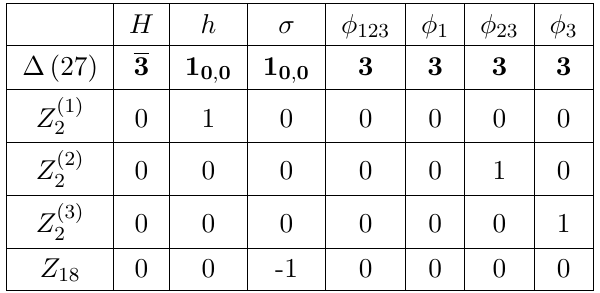
Table 1 . Scalar assignments under the ∆ (27) × Z (1) between the multiple Z 2